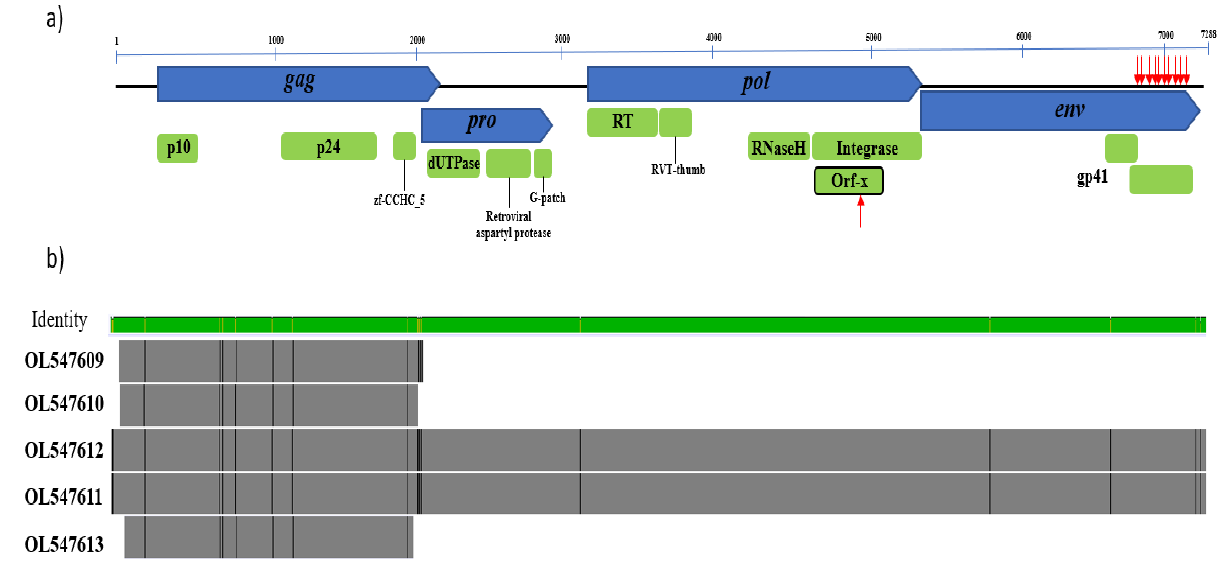
Figure 1. Genomic structure of CERV β1. ( a ) The core retroviral genes gag , pro, pol , and env are blue, while coding regions and predicted conserved domains are green. The position of aberrant stop codons is denoted with red arrows. ( b ) Alignment of the four detected retroviral contigs. Sequences OL547611 and OL547612 are nearly complete proviruses, while sequences OL547609, OL0547610, and OL0547613 matched the gag gene. Genome alignments are represented by the outlined bars in grey, with divergent sites highlighted in black. The green bar above indicates the percentage identity among the sequences (green is the highest identity).